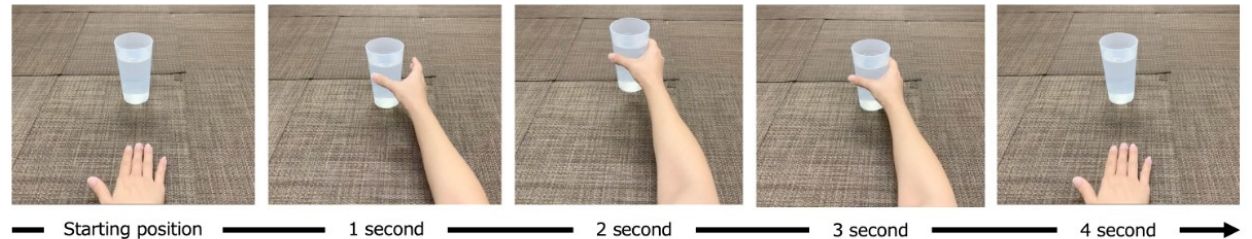
Figure 1. Motor imagery (MI) task of the paralyzed upper limb grasping a cup on a desk. The MI task consisted of a first-person viewpoint of reaching forward with the paralyzed upper limb to grasp a cup on a desk. This was performed while in a seated position without moving the trunk. Then, the movement proceeds with lifting the cup, returning the cup to the place on the desk, releasing the hand, and returning the paralyzed upper limb to its starting position in front of the trunk.